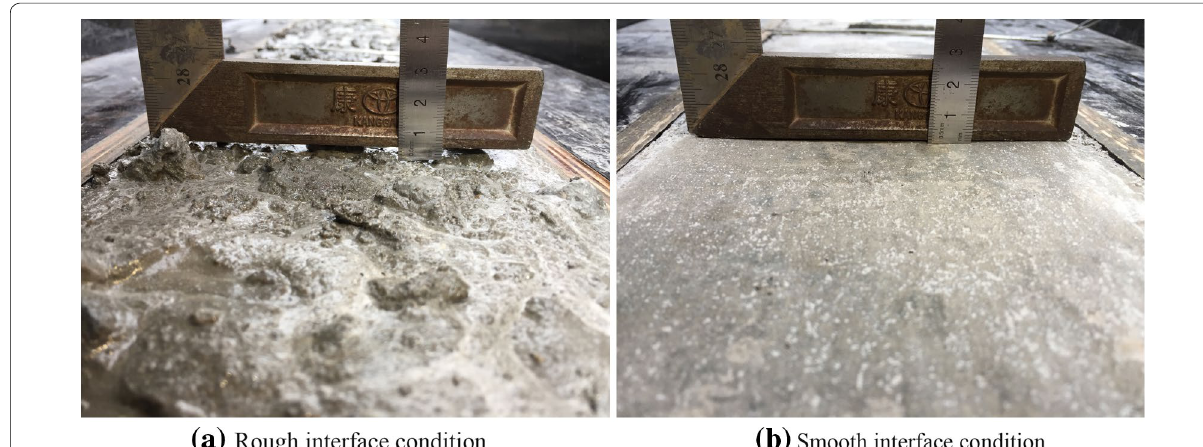
Fig. 3 Surface preparation.